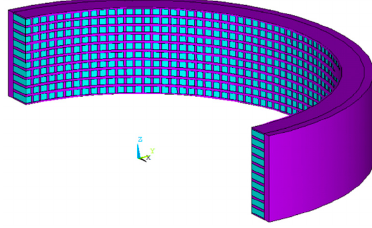
Figure 5. The structure of the simulation model.